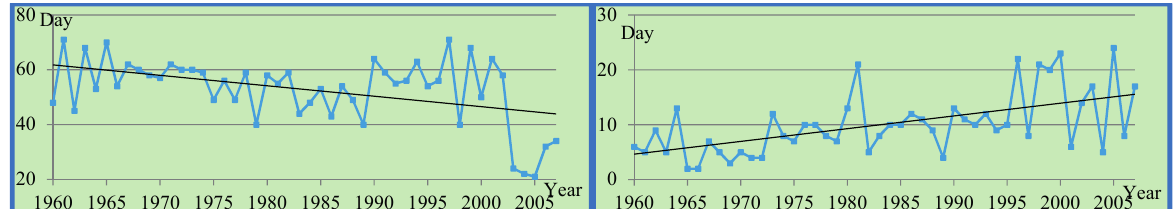
Figure 8. The most significant negative trend with a slope of − 0.4493 ( left ) and the most significant positive trend with a slope of 0.2942 ( right ) of the R20mm index.